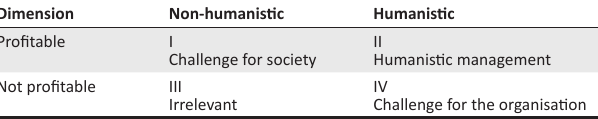
TABLE 1: Integrative model of humanistic management.